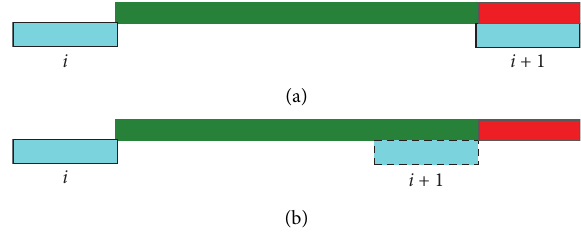
Figure 6: Strategy for demand restriction